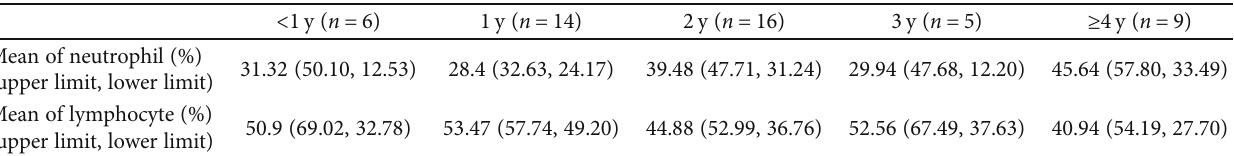
Table 3: Patients ’ characteristics and the means of neutrophil percentage and of lymphocyte percentage after the treatment of IVIG in di ff erent age groups.